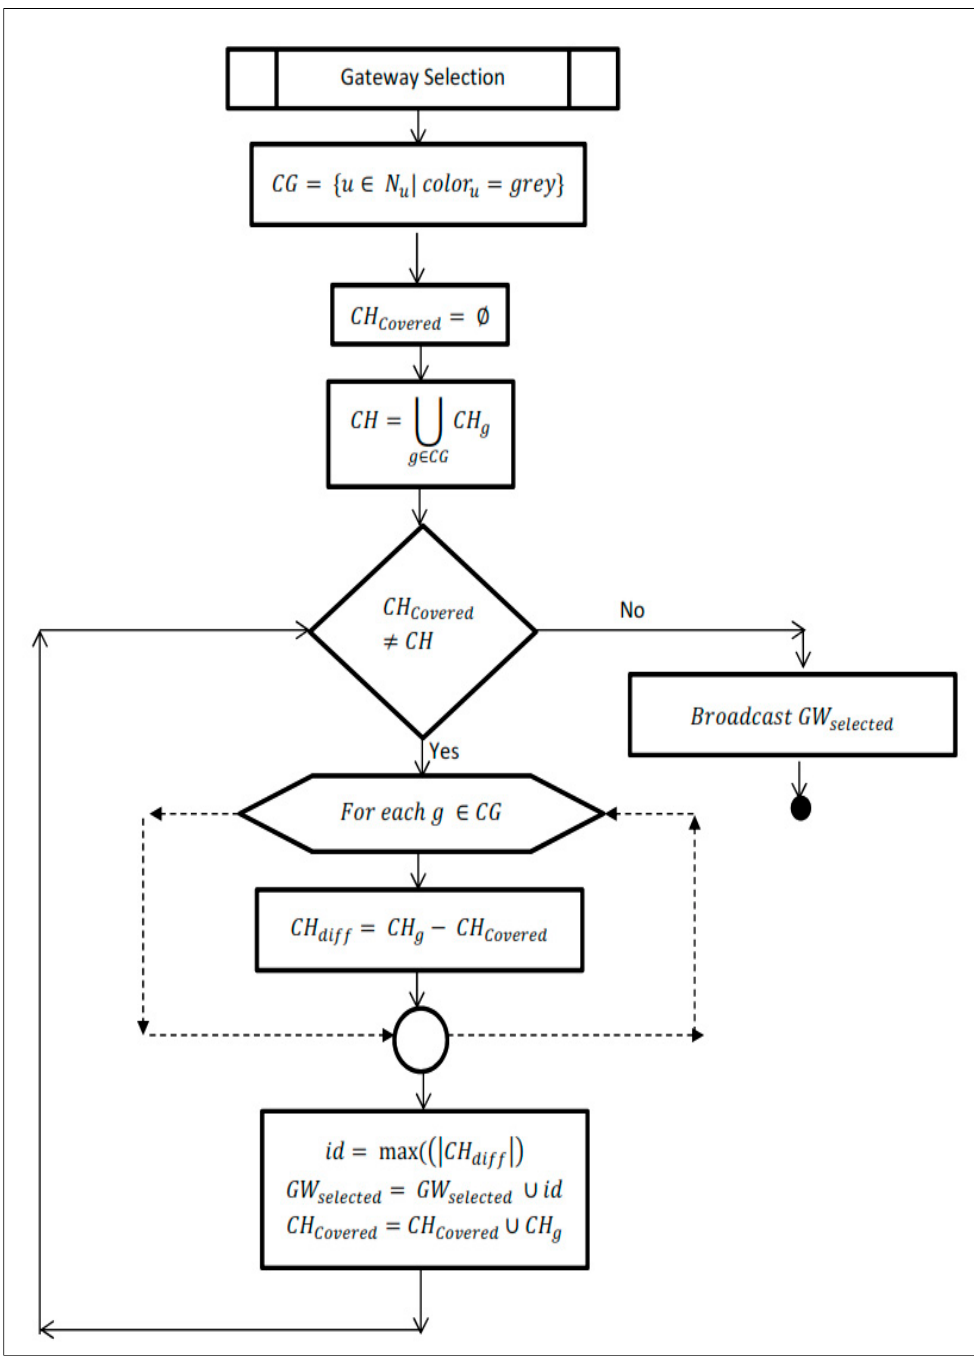
Figure 6. Gateway selection algorithm.